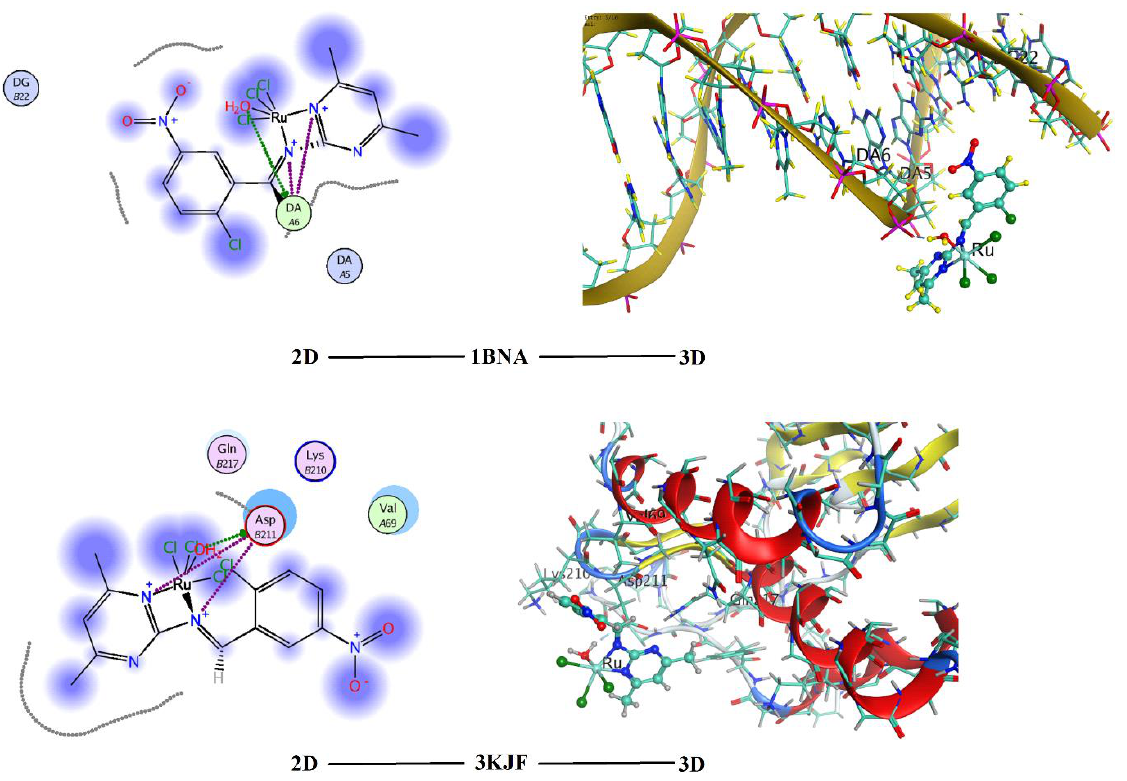
Figure 12. Molecular docking interactions (two-dimensional and three-dimensional) of the RuL complex with DNA (1BNA) and caspase 3 (3KJF).